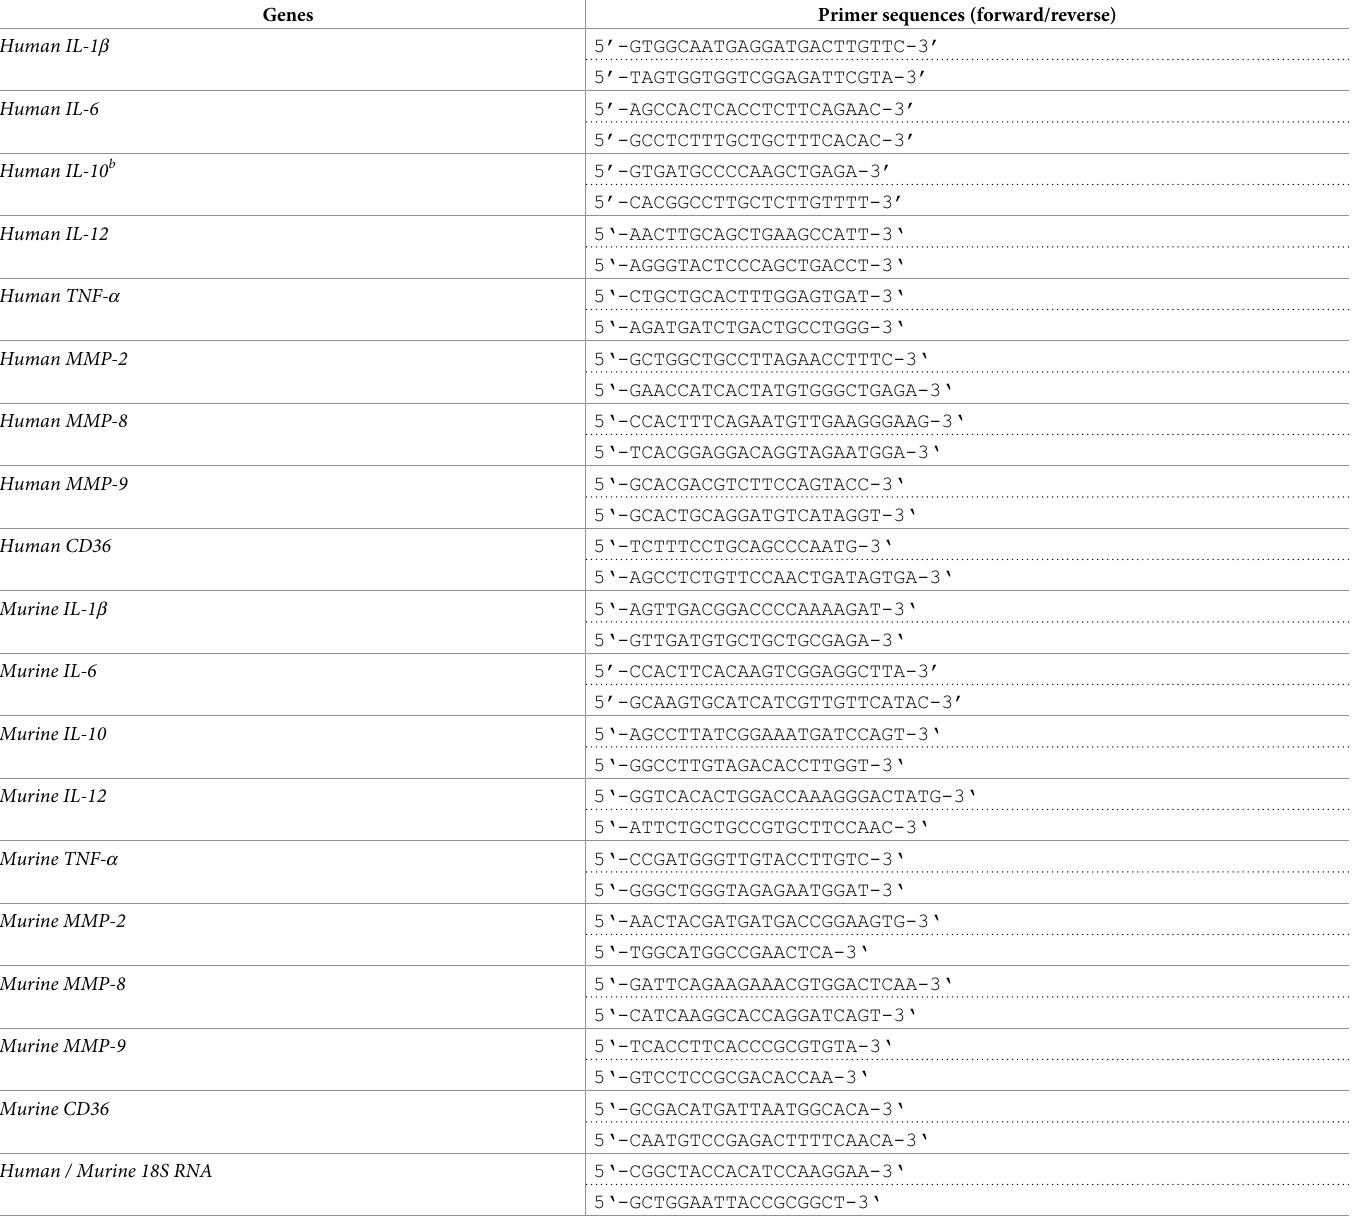
Table 1. Sequences of primer pairs used for Real-time